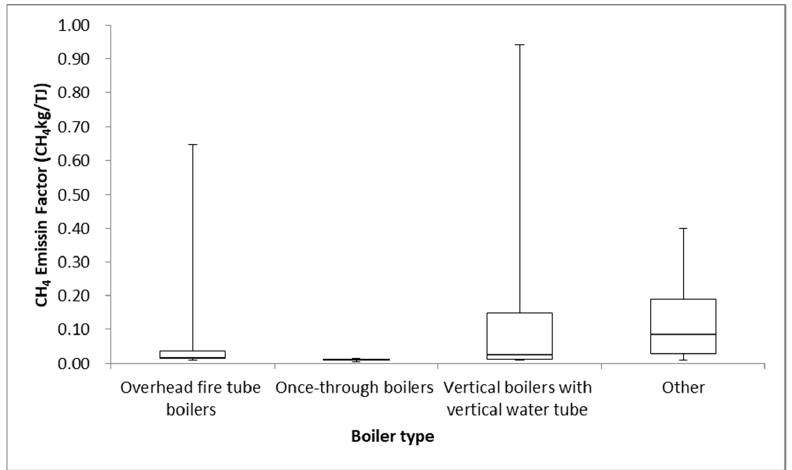
Figure 3. Box plot of developed CH 4 emission factor of boiler type.